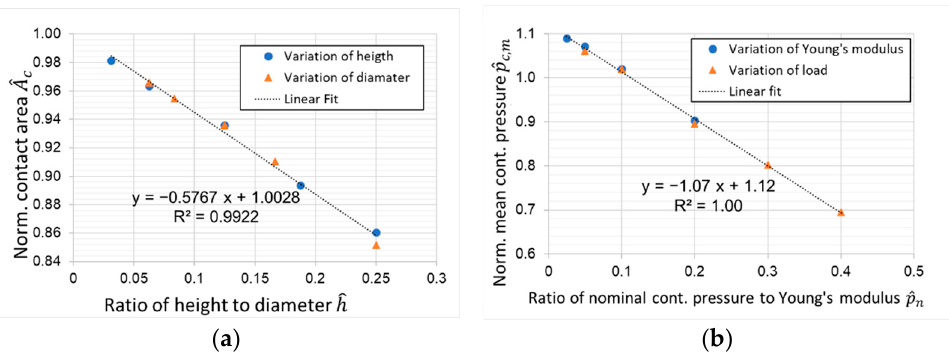
Figure 11. ( a ) Normalized contact area with contact pressure within ±10% of nominal pressure for different specimen geometries; ( b ) normalized mean contact